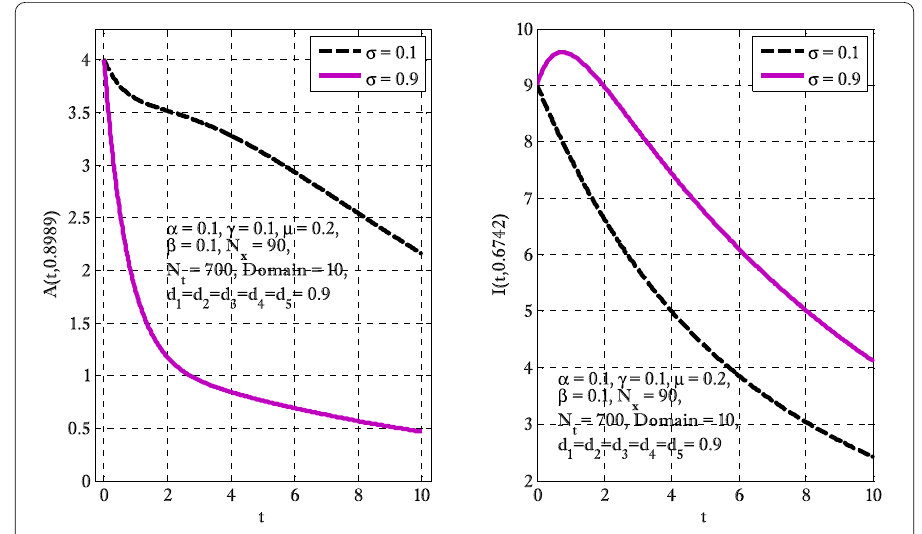
Figure 3 Asymptomatic and infected individuals with the variation of growth rate parameter